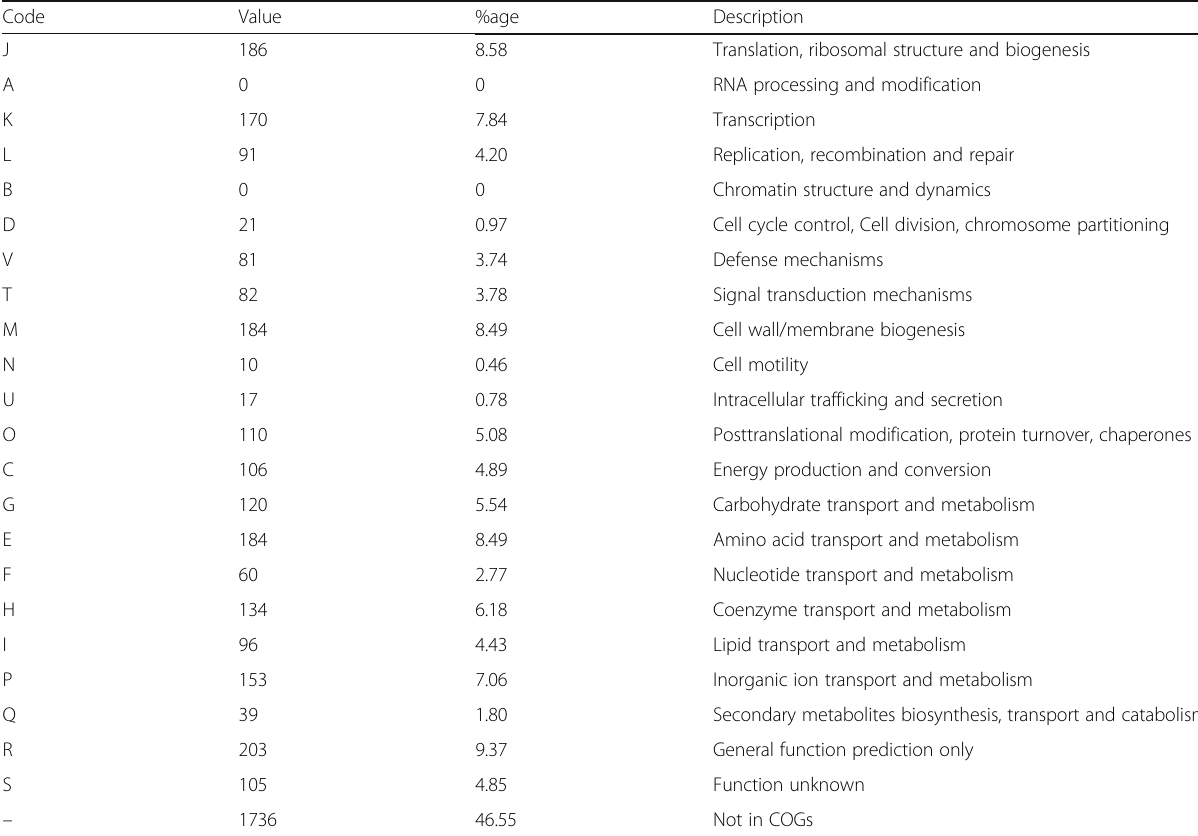
Table 5 Number of genes associated with general COG functional categories